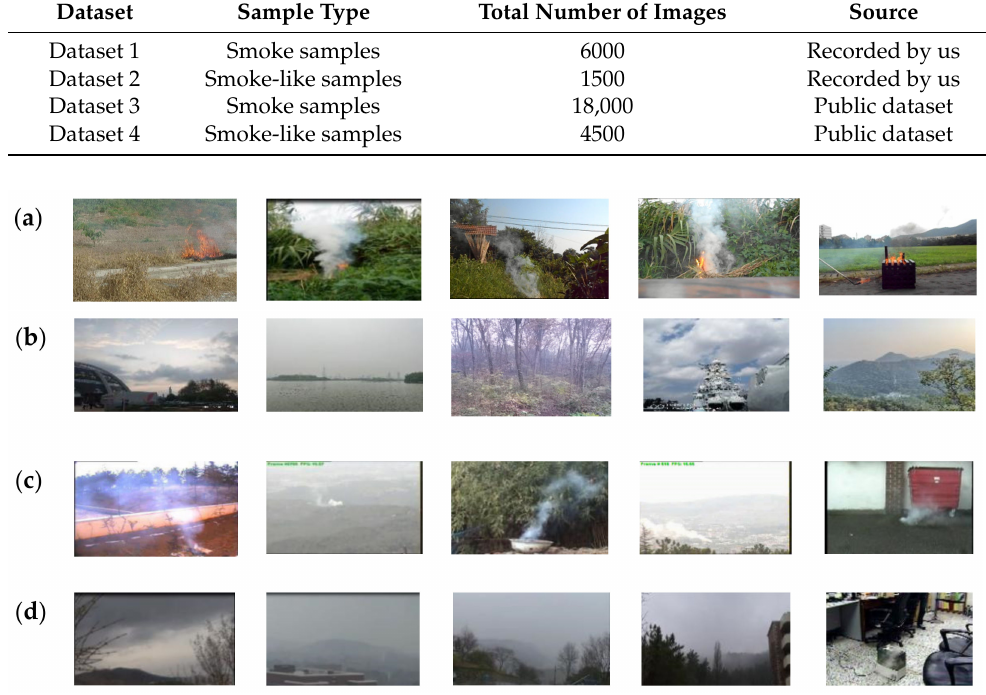
Table 2. Details of the datasets in the experiments.